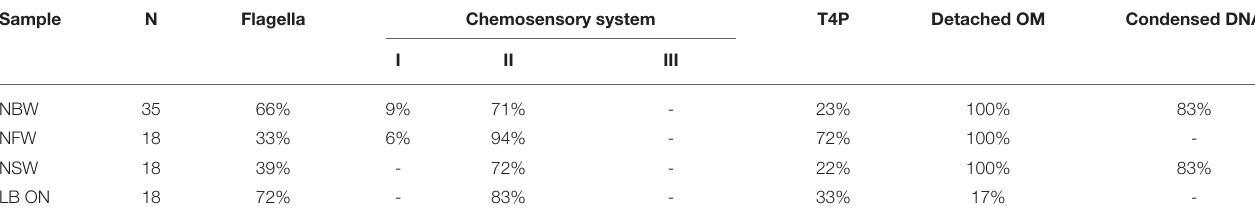
TABLE 1 | Quantification of occurrence of structures in cells from VBNC microcosms and LB ON cultures as observed by ECT. Sample N Flagella Chemosensory system T4P Detached OM Condensed